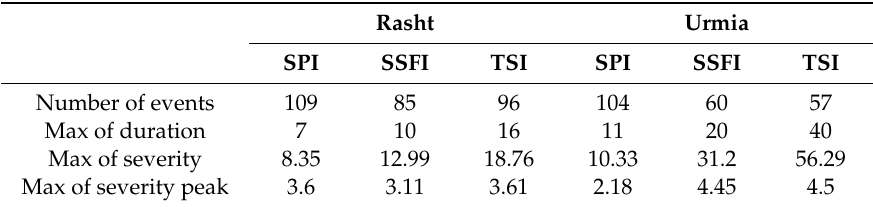
Table 5. Drought characteristics of two basins studied.